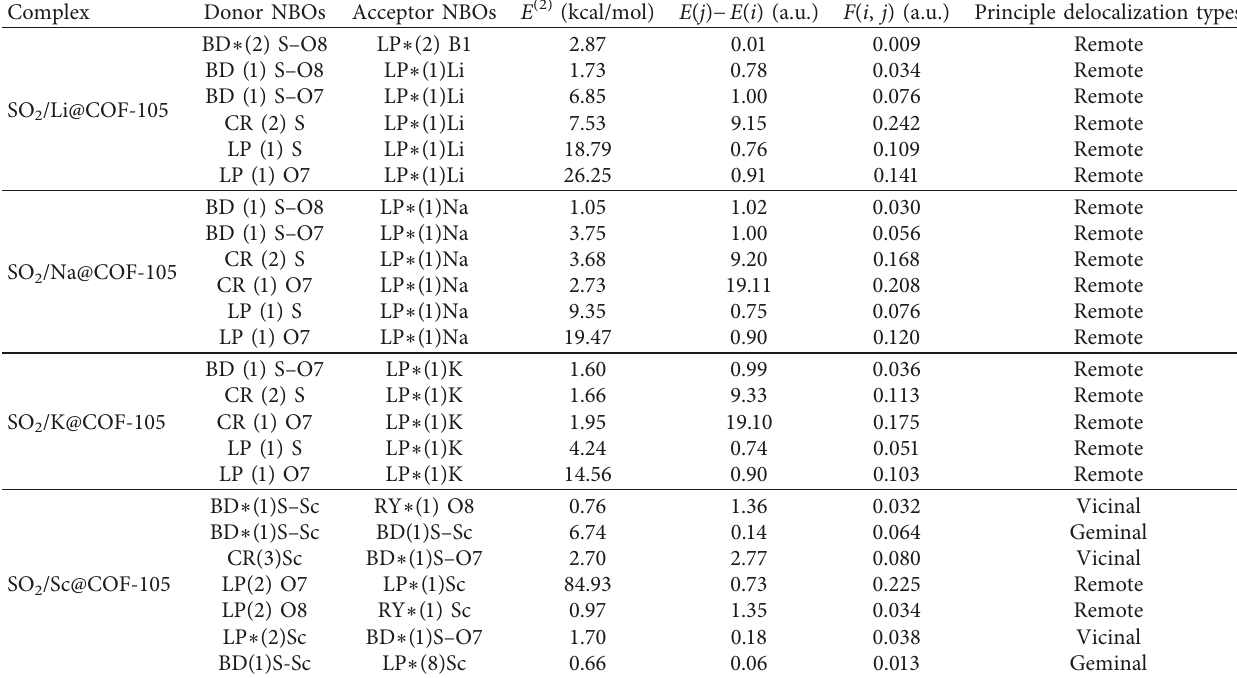
1 . 2 /metal@COF-105 (selected values)